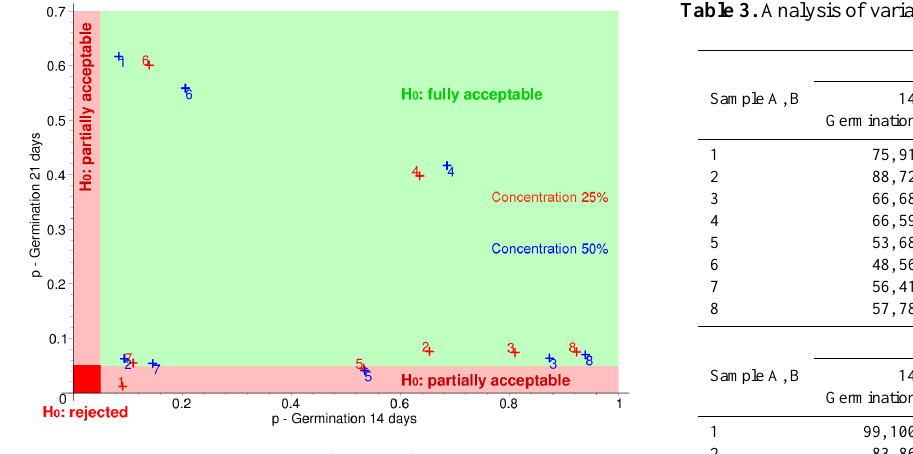
Figure 7. The values of p factor (ANOVA).